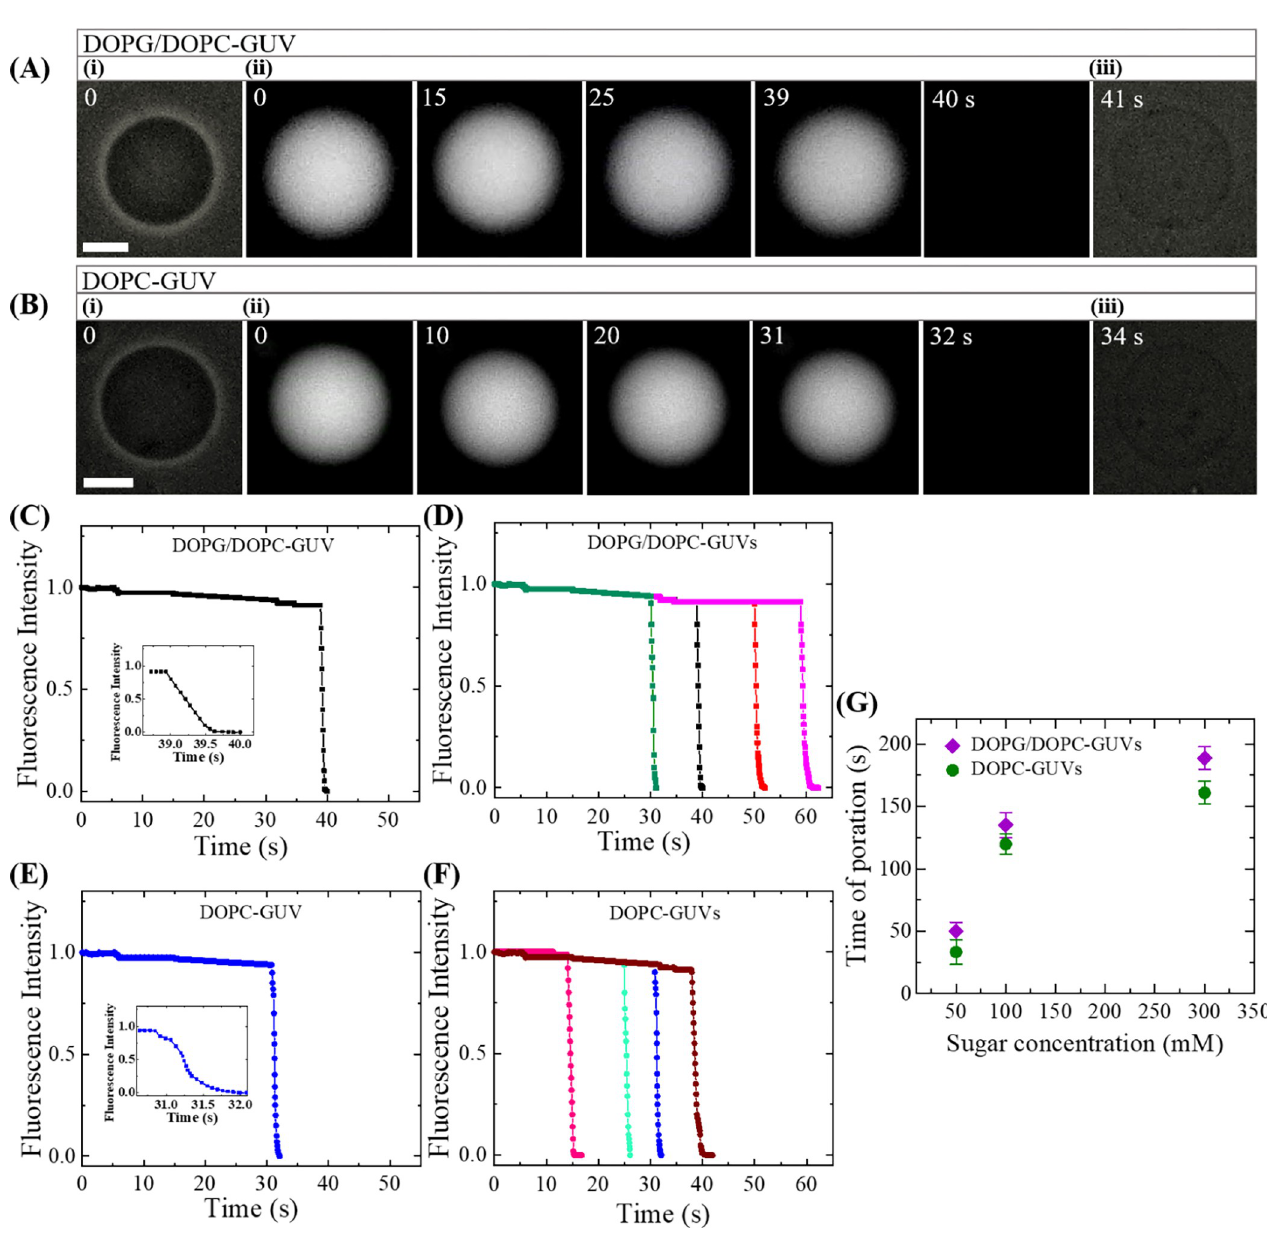
Fig 4. Pore formation in the membranes of GUVs induced by 3.33 μ g/mL NPs. Fluorescence images of (A) 40%DOPG/60%DOPC-GUVs and (B) DOPC-GUVs show the progressive decrease of calcein from inside the GUVs at 50 mM sugar concentration. The numbers on each image show the time in seconds after the NPs are added in the suspension of GUVs. The bar corresponds to 15 μ m. Time course of the change of normalized fluorescence intensity of calcein for (C) 40%DOPG/60%DOPC-GUVs and (E) DOPC-GUVs as shown in (A) and (B), respectively. (D, F) Under the same condition corresponding to (C) and (E), the change in normalized fluorescence intensity with time for many GUVs under 50 mM sugar concentration. (G) Sugar concentration-dependent average time of pore formation in 40%DOPG/60%DOPC and DOPC-GUVs. the interaction of 3.33 μ g/mL NPs under 50 mM sugar concentration. Before interacting NPs with the surface of GUVs, it had a high contrast in phase contrast image at 0 s as shown in Fig 4A(i) and 4B(i) due to the difference of refractive index between the internal (sucrose) and external (glucose) solutions of GUVs. The corresponding GUVs in fluorescence microscopy are shown in Fig 4A(ii) and 4B(ii), which showed high concentration of fluorescent material in